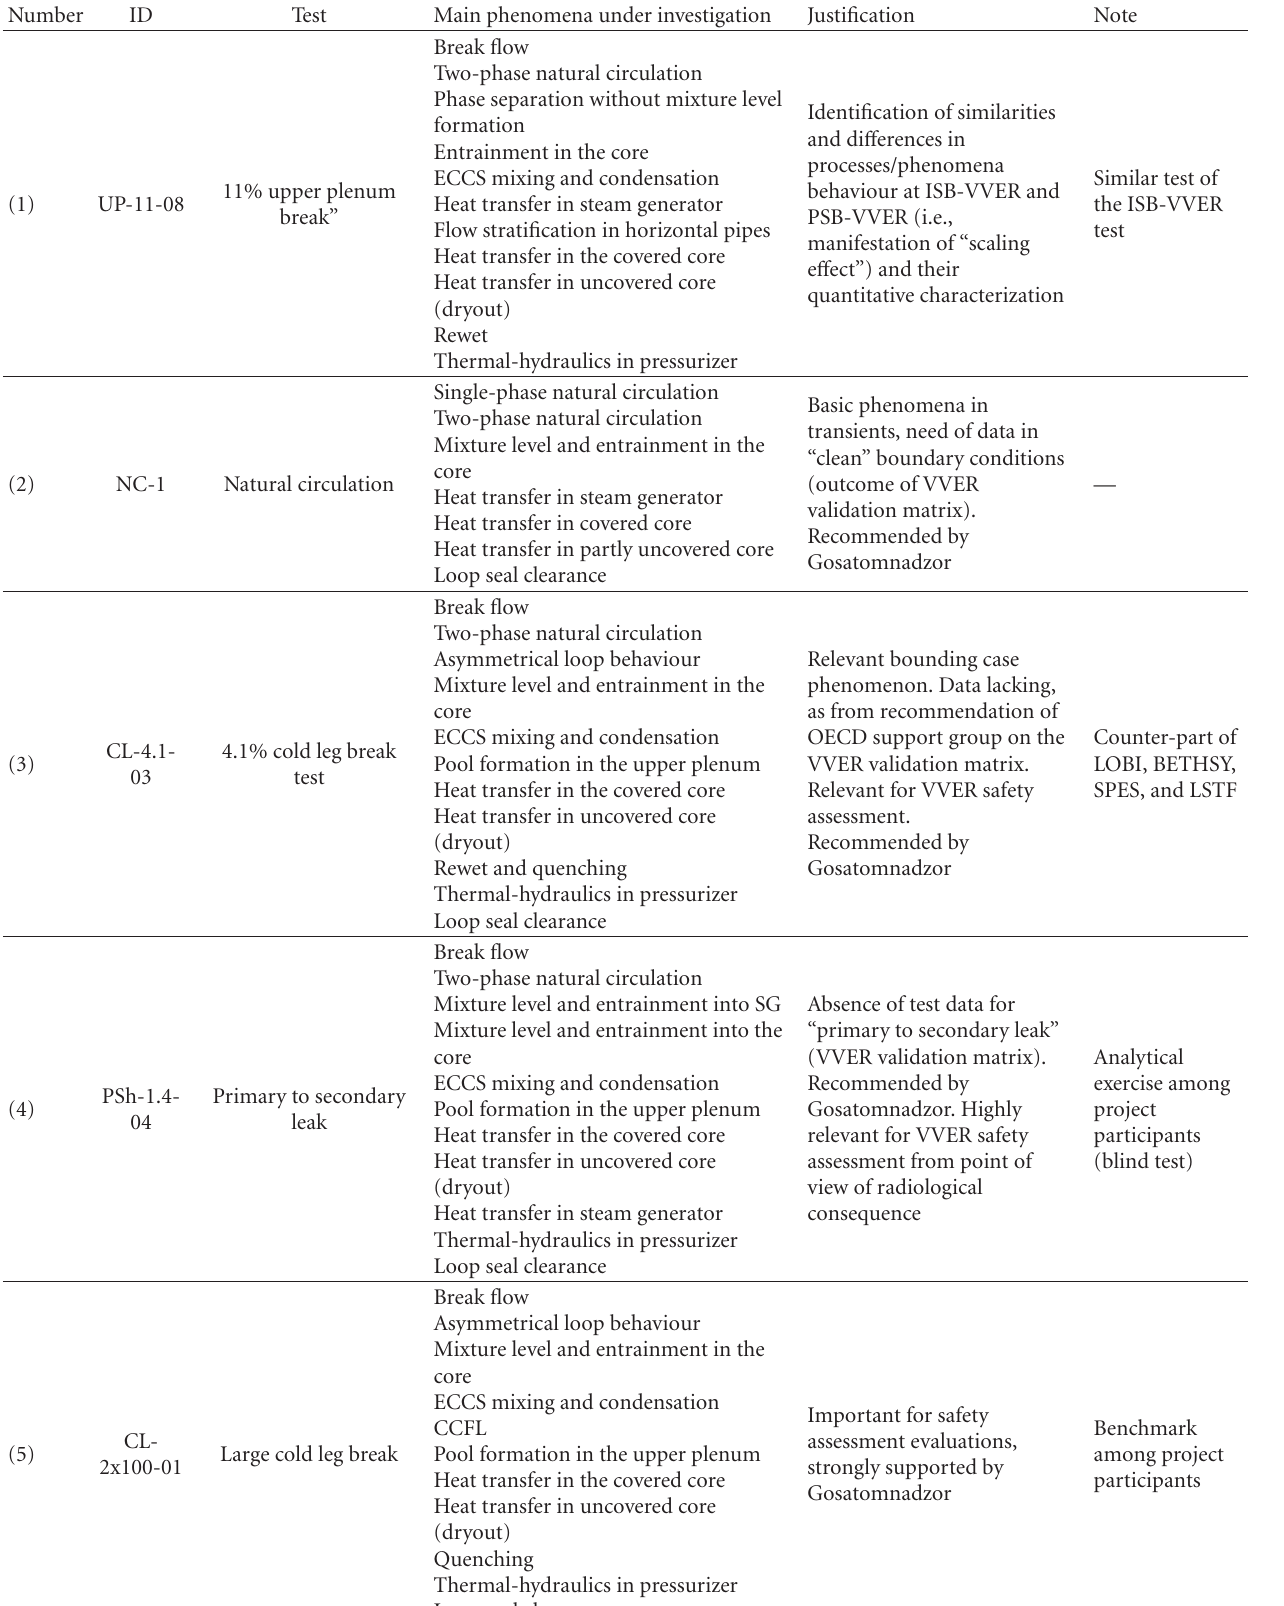
Table 1: OECD/NEA PSB-VVER project: test